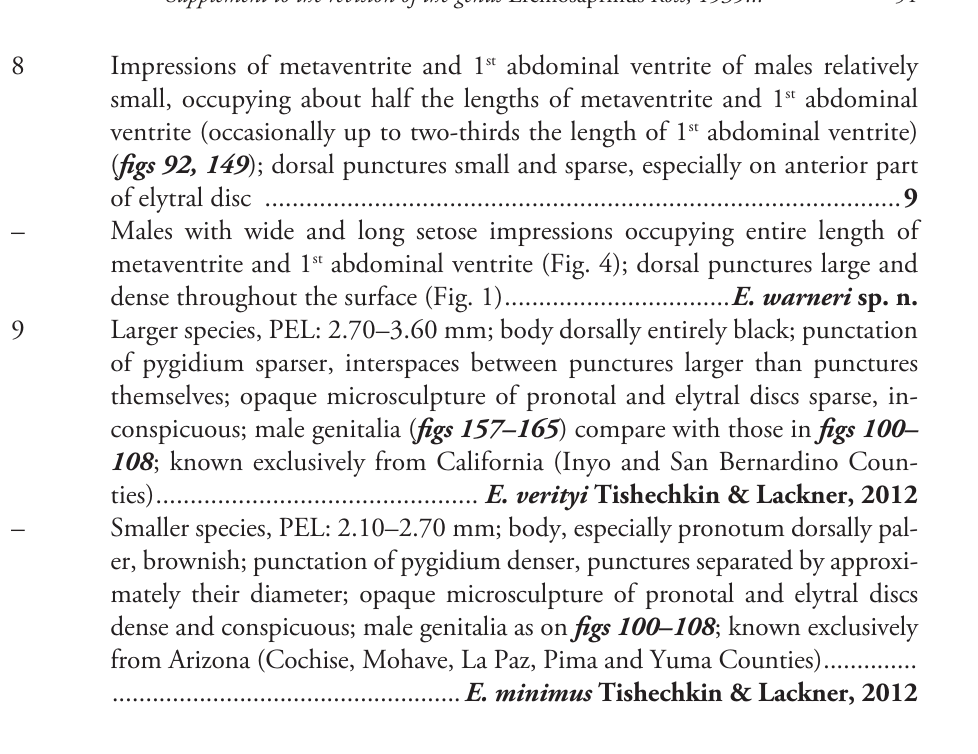
Type material. Holotype, point-mounted male, labeled “USA: AZ: Cochise Co., Bagby Rd., 0.2 mi W Central Hwy.; 31°33'14"N, 109°42'06"W; viii.28.– x.9.2011; barrier pitfalls; W. B. Warner / HOLOTYPE Eremosaprinus warneri sp. n. A.K.Tishechkin & T.Lackner des. 2012” (FMNH). Paratypes (46, in CTLA, CWBW, FMNH and LSAM): 6 ♂♂ and 12 ♀♀ females labeled as the holotype; 3 ♂♂ and 1 ♀ as preceding, but collected on 28.viii.–19.xi.2011; 4 ♀♀ with the same locality, collector and collecting method, but collected on 9.x.–19.xi.2011; 2 ♀♀ with the same locality, collector and collecting method, but collected on 12.viii.–5. ix.2012; 3 ♂♂ and 6 ♀♀ with the same locality, collector and collecting method, but collected on 5.ix.–6.x.2012; 3 ♀♀ from Arizona, Cochise Co., Birch Rd., 4.1 mi E of Highway 191 at 31°58'43"N, 109°46'41"W, collected by black cup pitfall traps on 28.vii.–9.x.2011 by W. B. Warner; 1 ♂ and 4 ♀♀ from Arizona, Cochise Co., 1.5 mi S junction of Highways 191 and 181 at 31°51'44"N, 109°41'59"W, collected by black cup barrier pitfall traps on 28.viii.–9.x.2011 by W. B. Warner;